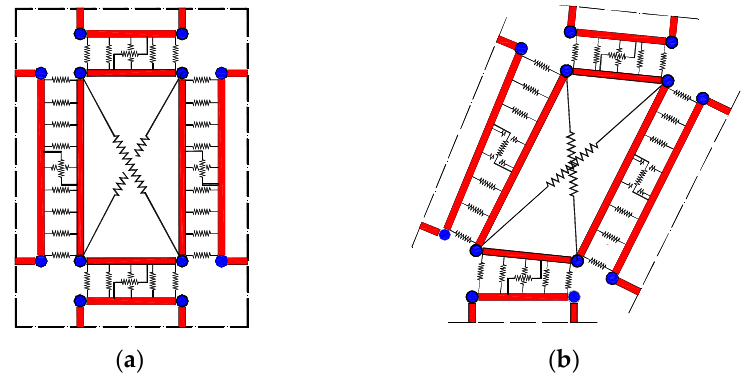
Figure 6. The basic macro-element for the masonry infill: ( a ) undeformed configuration; and ( b ) deformed configuration.